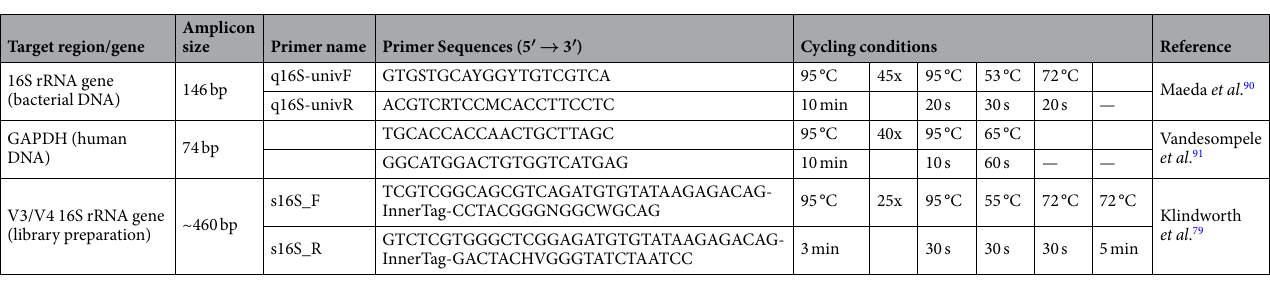
Table 3. Primers and cycling conditions used in this